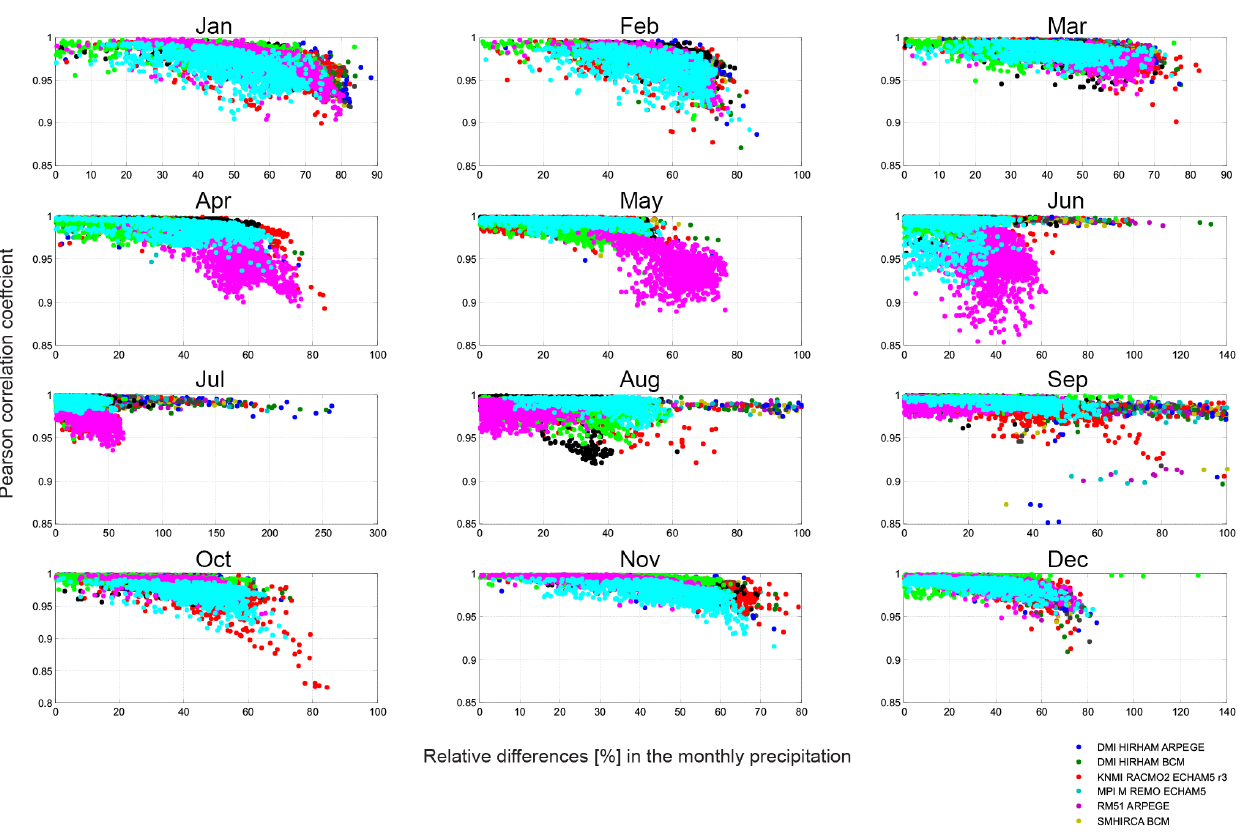
Figure 15. The scatter plots showing relationship between relative differences in the raw and corrected monthly sum of precipitation and Pearson correlation coefficient estimated for raw and corrected SPI 1 values for all grid